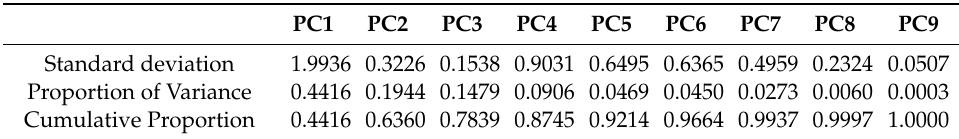
Table 5. Importance of components for analyzed